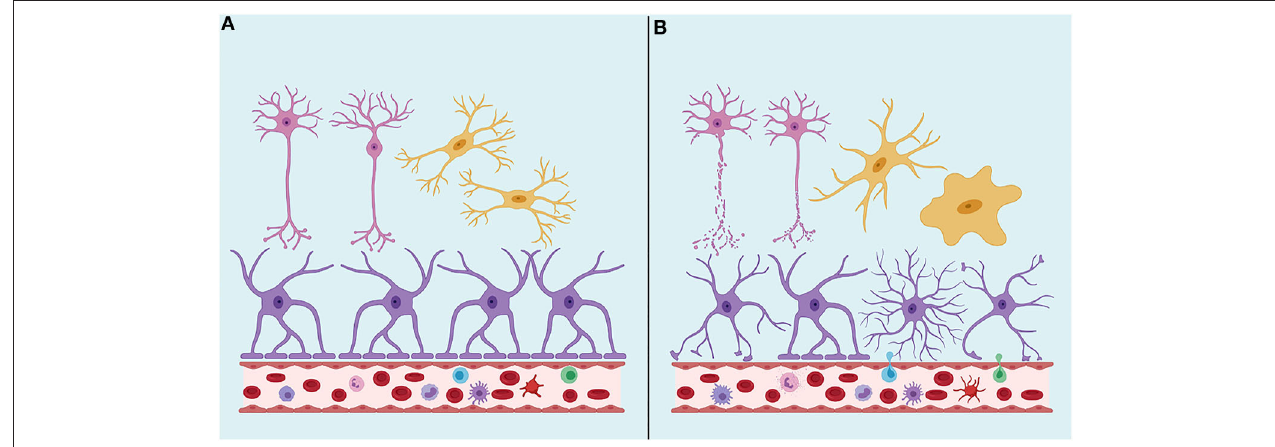
FIGURE 1 | (A) Under physiological conditions, the Brain-Blood Barrier (BBB) creates a restrictive barrier between central nervous system and circulating blood contents. BBB is formed by astrocyte endfeet, pericytes and tight junctions among endothelial cells. (B) After a traumatic brain injury (TBI), BBB may become dysfunctional. TBI may also lead to axonal shearing, activation of microglia, astrocytes, and peripheral immune cells, often resulting in neuroinflammation, edema, neuronal hyperexcitability, and cell death. Neurons are represented in pink, astrocytes in purple and microglia in yellow. Created with